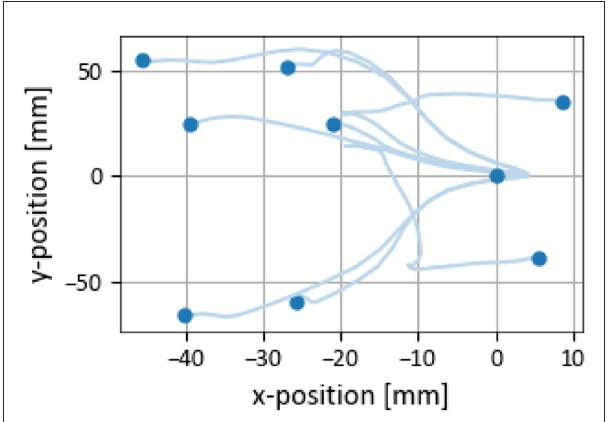
FIGURE6 Head trajectories in the pre-crash phase measured in the local coordinate system. Markers indicate the end positions at the time of collision that are used for